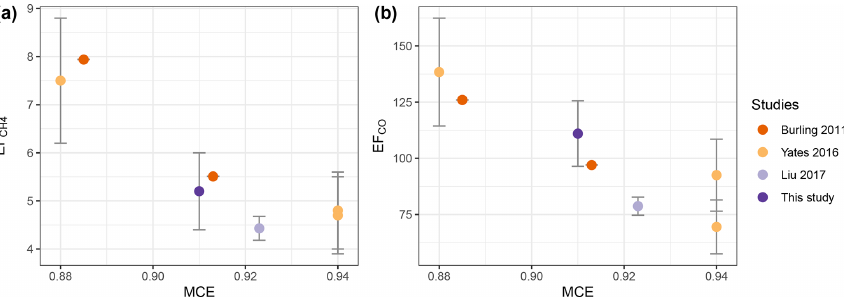
Figure 6. Emission factors (gkg − 1 ) for (a) CH 4 and (b) CO as a function of MCE for temperate coniferous forests from Sierra Nevada